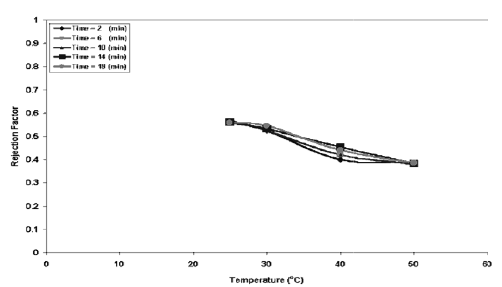
Fig.6. T the red d 4.2.3 Eff